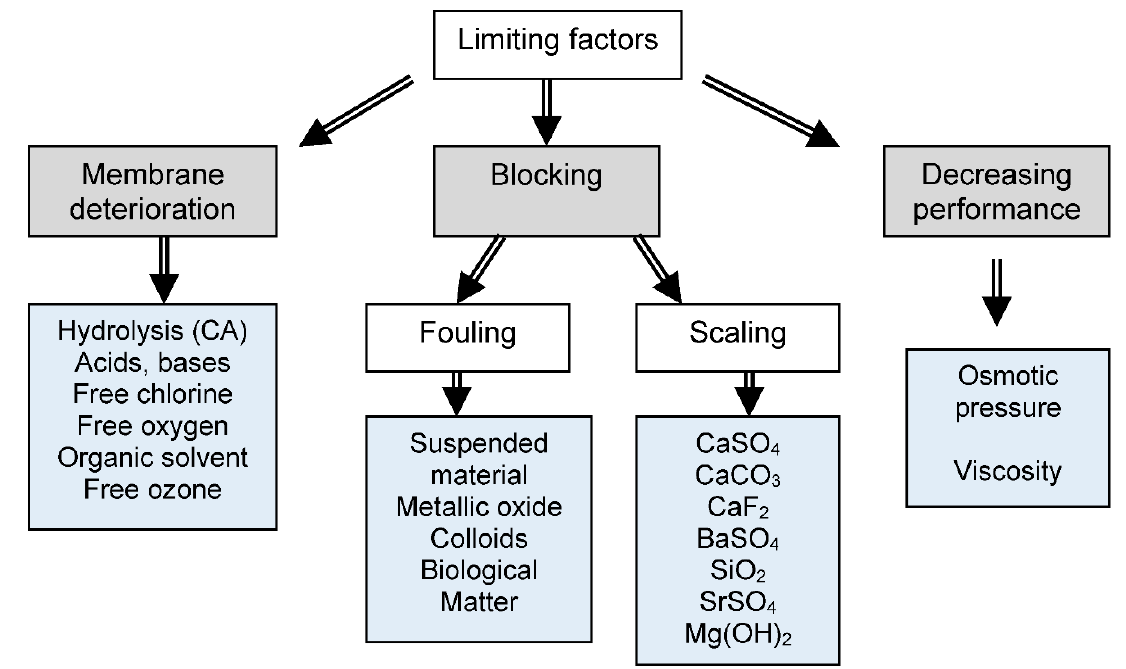
Figure 4. Limiting factors to membrane desalination by reverse osmosis (adapted from [1])